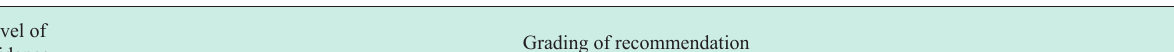
Table 1 Levels of evidence and grading of